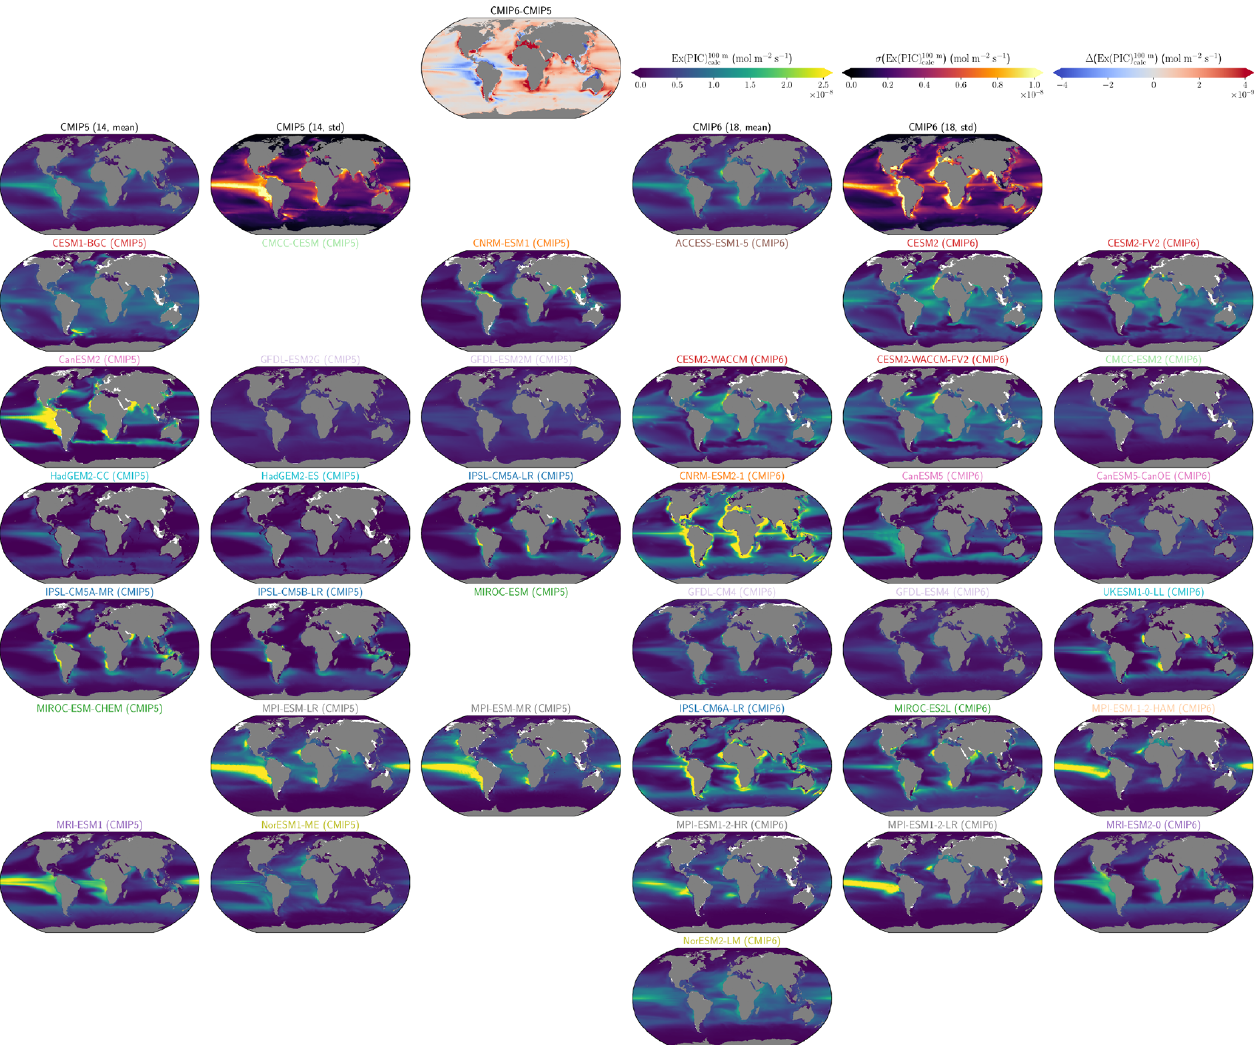
Figure D3. Distribution of the calcite export at 100m. ESM intercomparison of the calcite export at 100m as simulated by ocean biogeo- chemical models involved in CMIP5 (first three columns) and CMIP6 (last three columns). The first row gives the difference between the CMIP6 and CMIP5 ensemble means. The second row gives the ensemble mean and standard deviation for each CMIP.